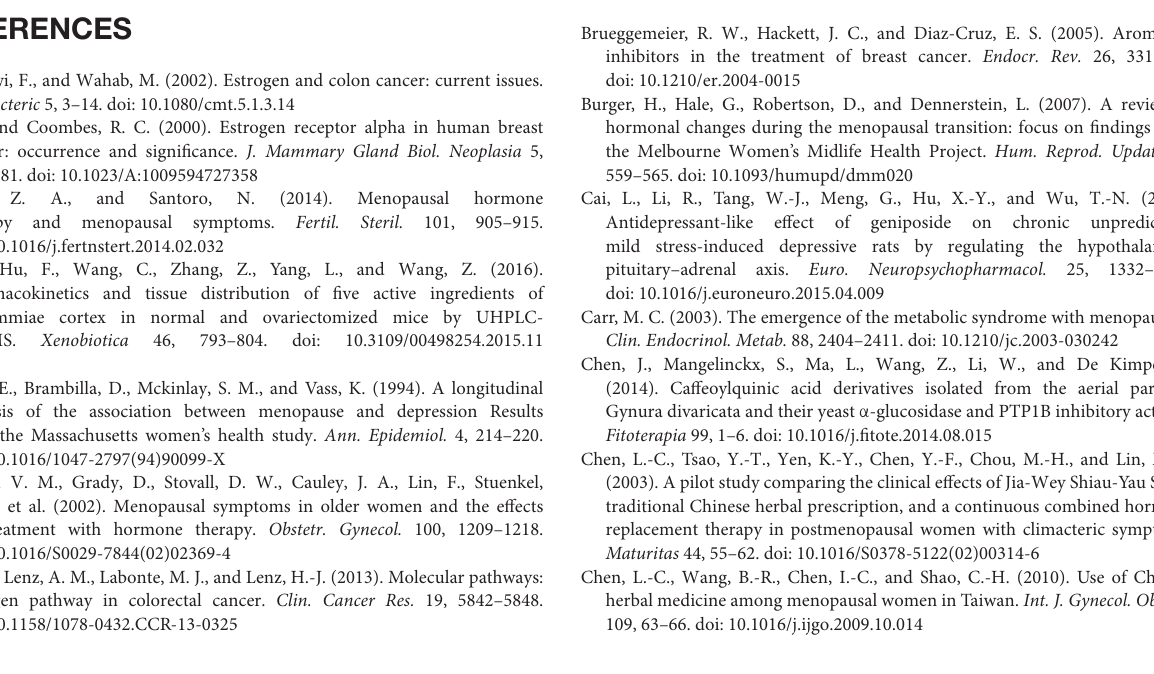
Table S3 | Precision study of sample solution of geniposide. Table S4 | Stability study of sample solution of geniposide. Table S5 | Recovery study of sample